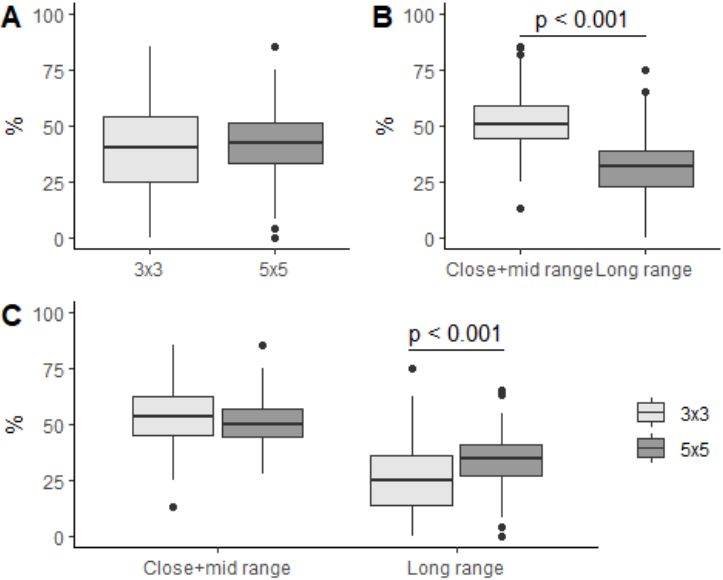
Figure 3. Shooting percentage regarding basketball discipline ( A ), range of shot ( B ), and their interaction ( C ).